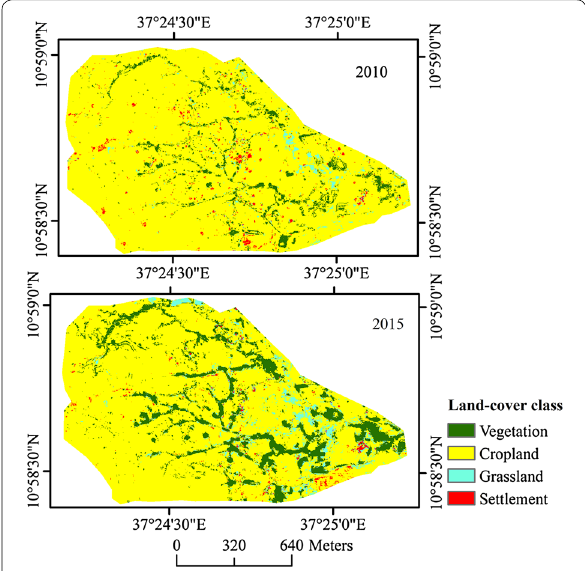
Fig. 2 Map showing the land covers type of the study area in 2010 and